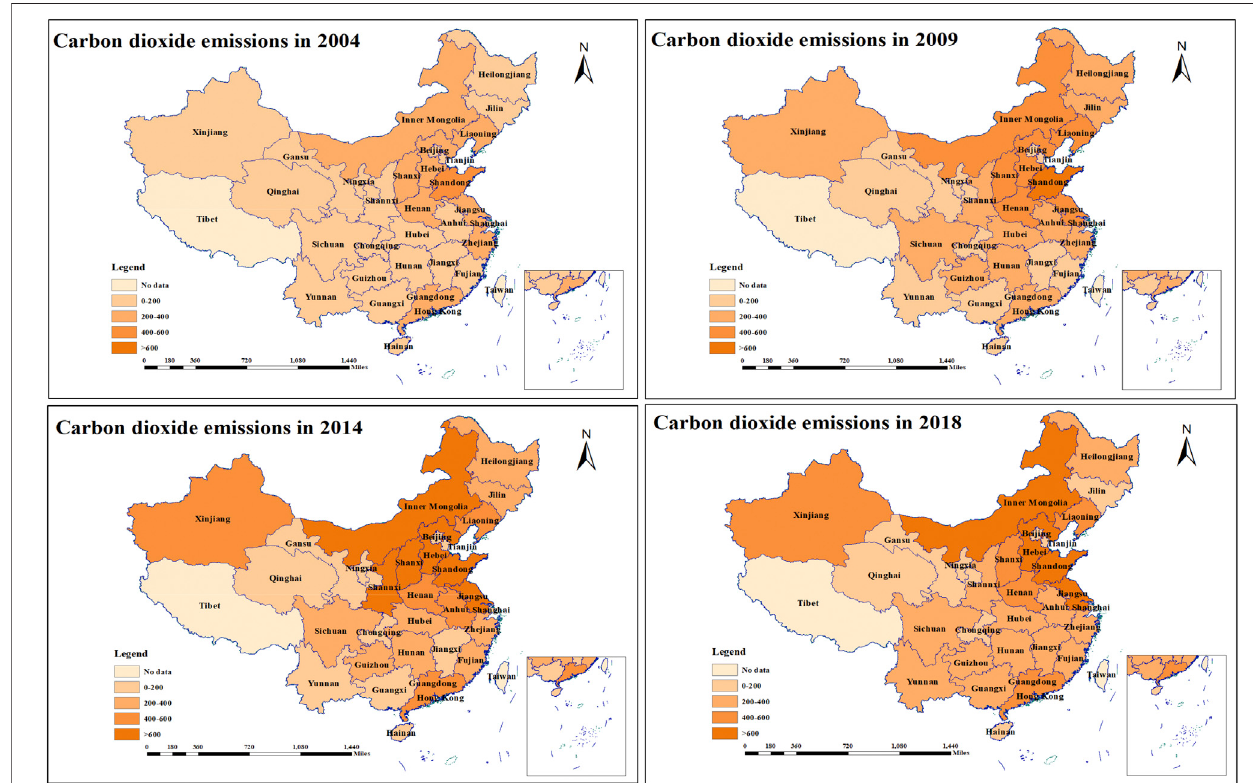
FIGURE 2 | Spatial distribution of CO 2 emissions in selected